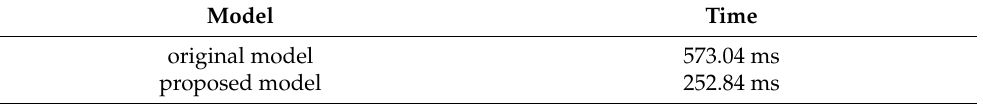
Figure 9. Actual running results of the target recognition system. ( a ) is on cpu identification. ( b ) is on gpu identification. Table 2. Compute the time consumption of the model on cpu before and after